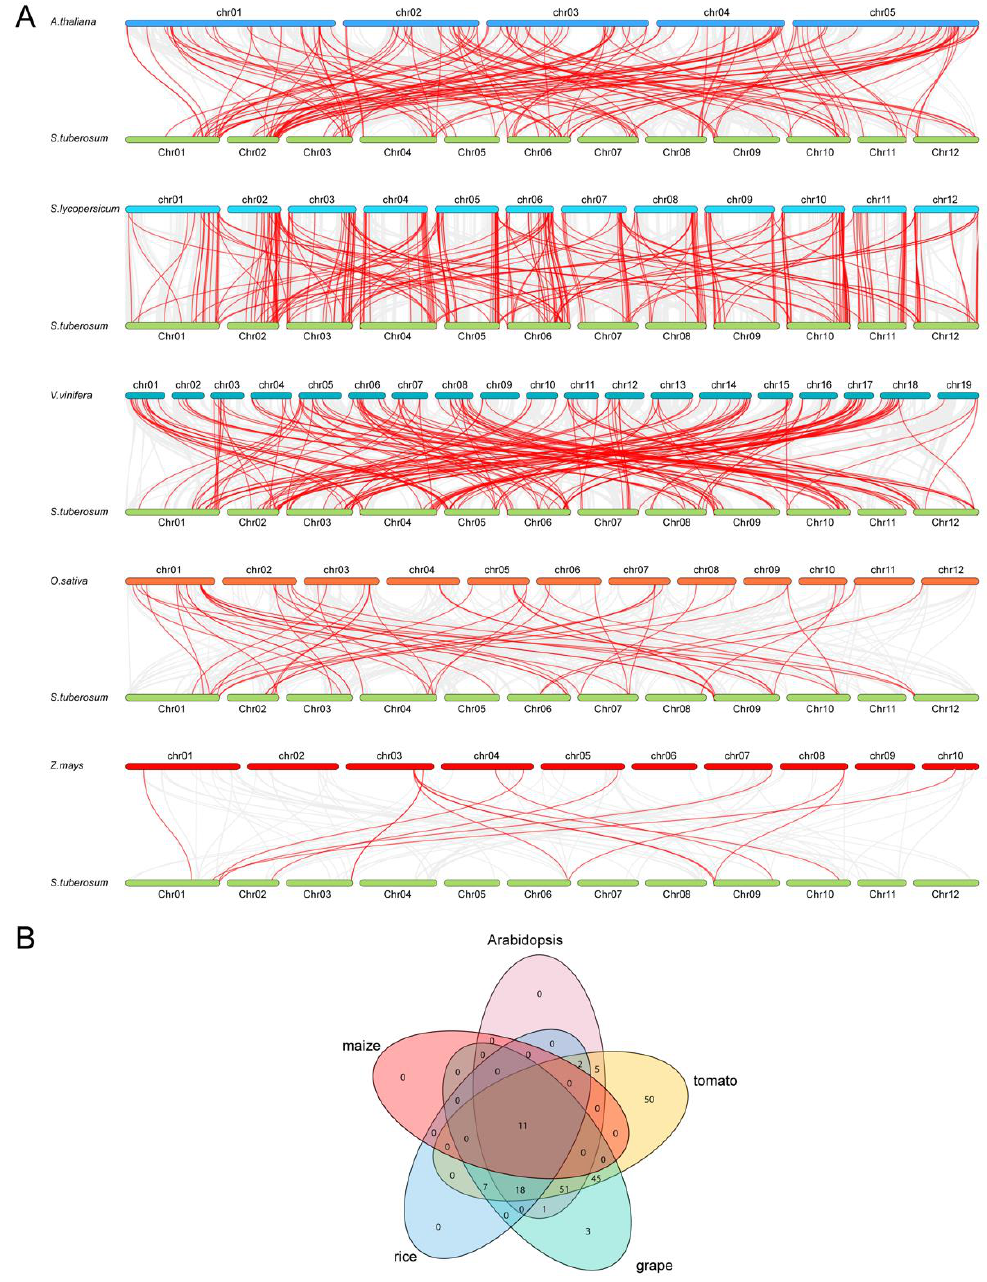
Figure 3. Synteny analysis of MYB genes between potato and five other representative species. ( A ) The gray line in the background represented the collinear blocks between potato and five other representative species, while the red line exhibited the syntenic MYB gene pairs. ( B ) The MYB genes formed the syntenic pairs between potato and all the other five selected species, which was visualized by the Venn plot.